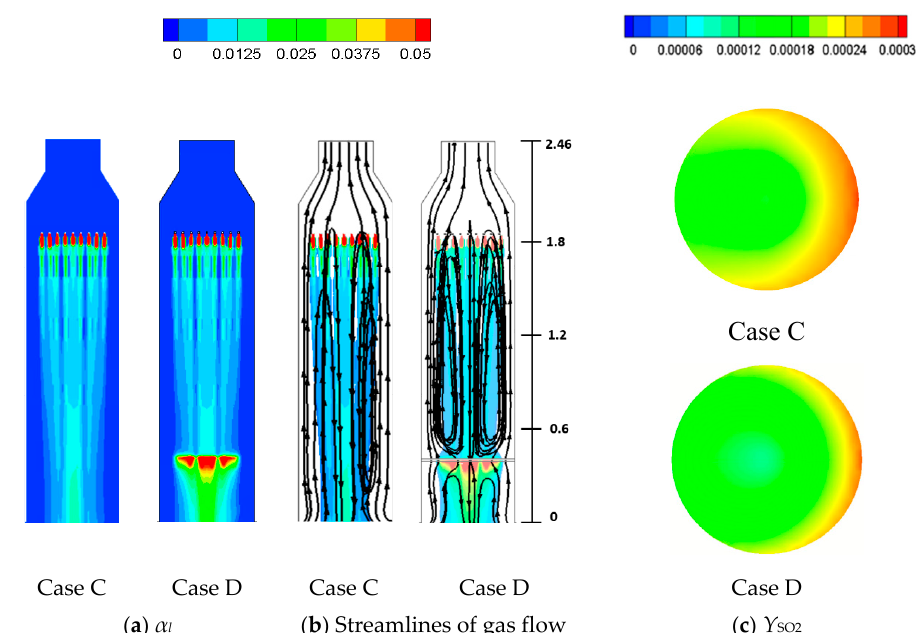
Figure 15. The figure displays ( a ) the liquid volume fraction, ( b ) streamlines of gas flow, and ( c ) the mass fraction of SO 2 from the top view at y = 0.615 m for Case C (empty tower) and Case D (one- tray tower).